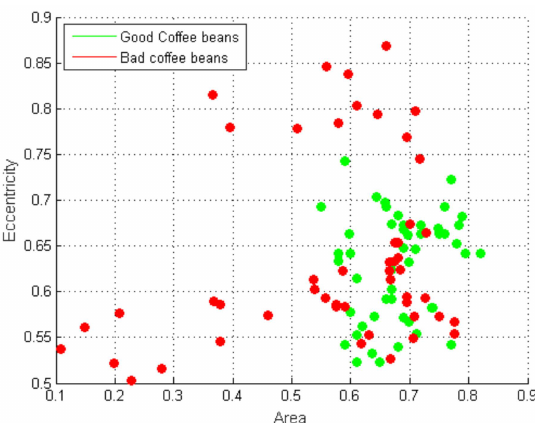
Figure 16. 2D plot of eccentricity and area features used for the k -nearest neighbor algorithm using the training